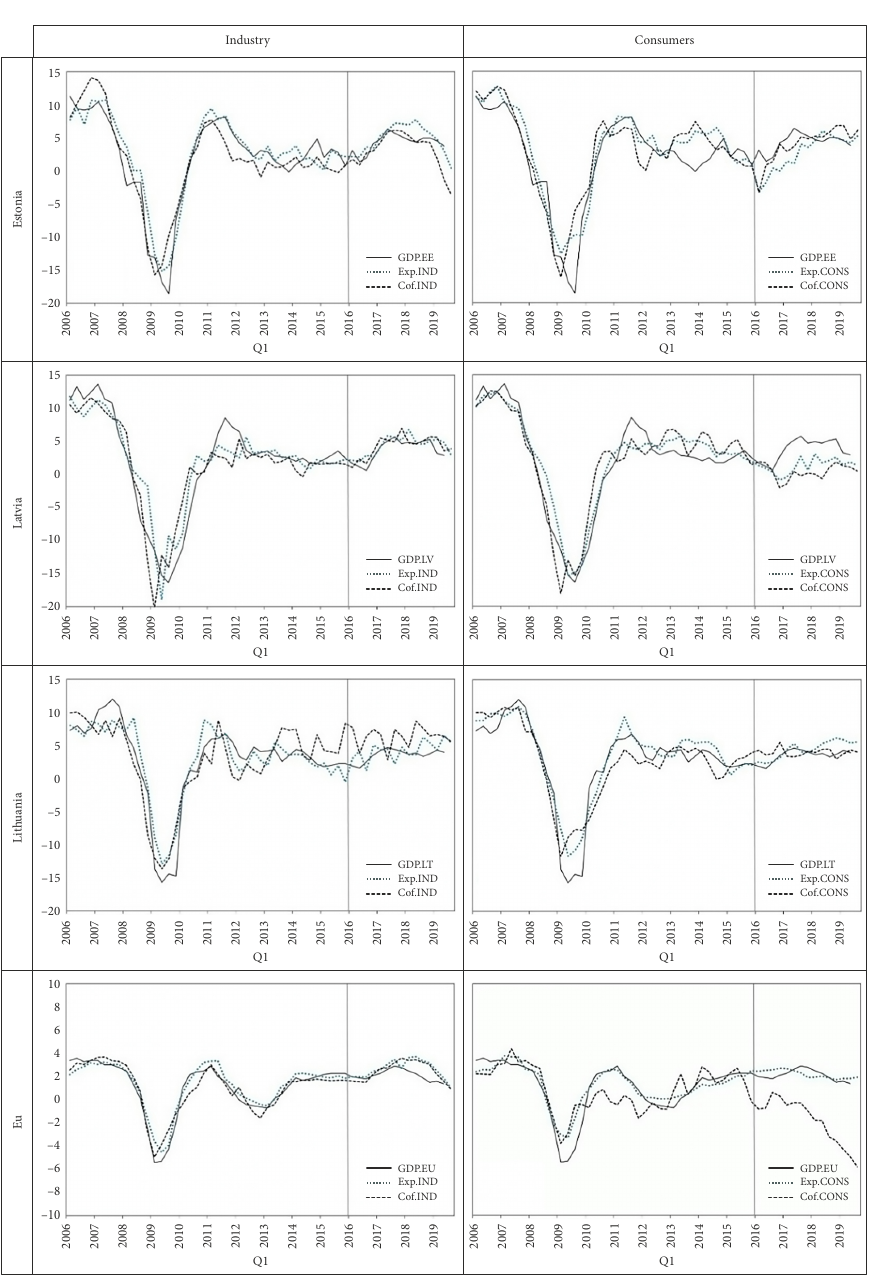
Figure 3. Evolution of GDP, evolved expectations and scaled confidence indicators Notes: The black line represents the evolution of year-on-year GDP growth rates for each country, the grey dotted line that of firms’ and consumers’ expectations obtained with the evolved indicators (Exp. IND and Exp.CONS), and the dashed black line that of the scaled EC confidence indicators (Cof.IND and Cof.CONS). The vertical line in 2016:Q1 marks the beginning of the out-of-sample